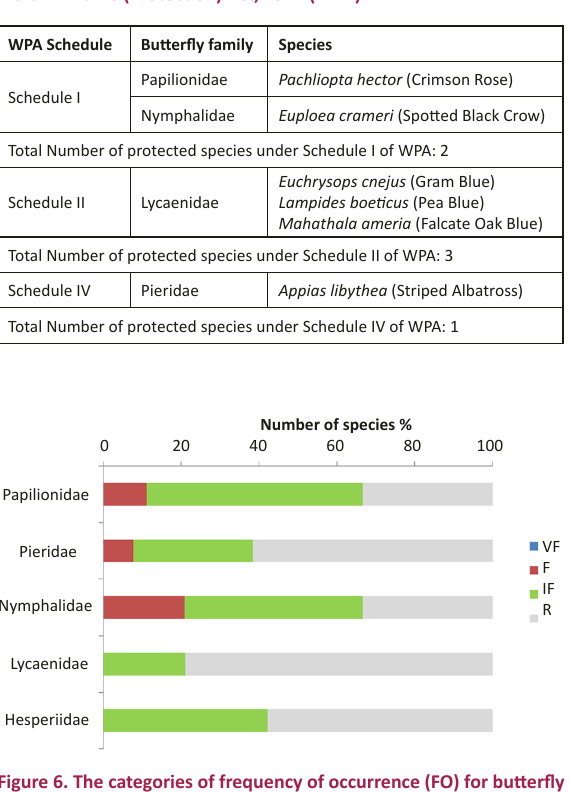
Figure 6. The categories of frequency of occurrence (FO) for butterfly families in Indian Sundarbans. VF = Very Frequent; F = Frequent; IF = Infrequent; R = Rare. Typical features include absence of ‘Very Frequent’ class and presence of ‘Rare’ class in maximum, with lycaenids and hesperiids taking the greatest